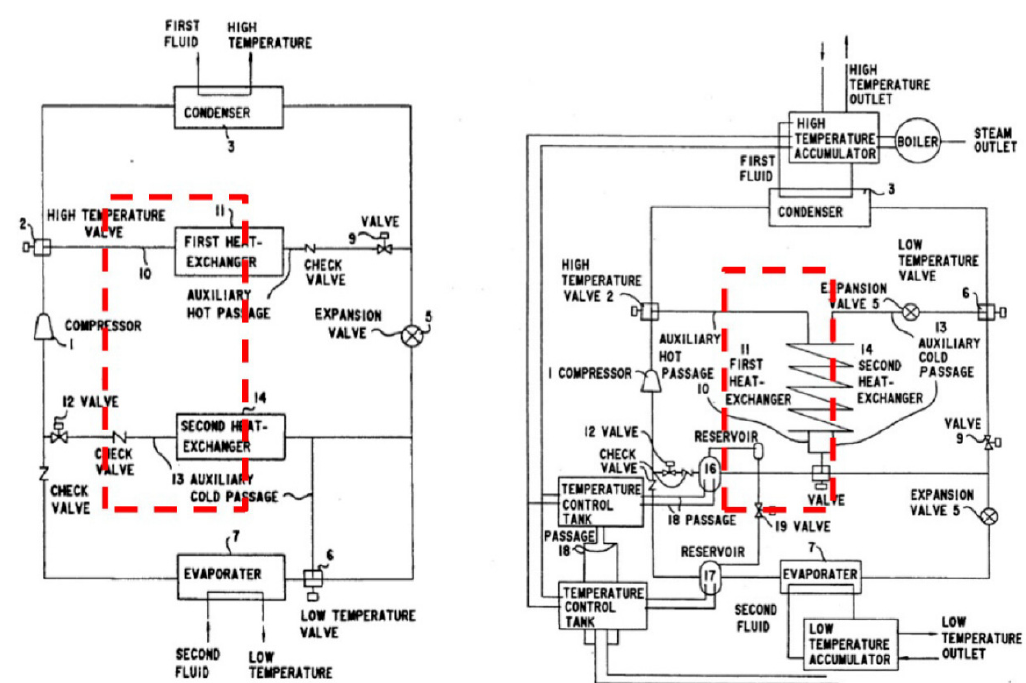
Figure 19. Schematic diagram of the patent of Union Kogyo Kabushiki Kaisha (US5211023).